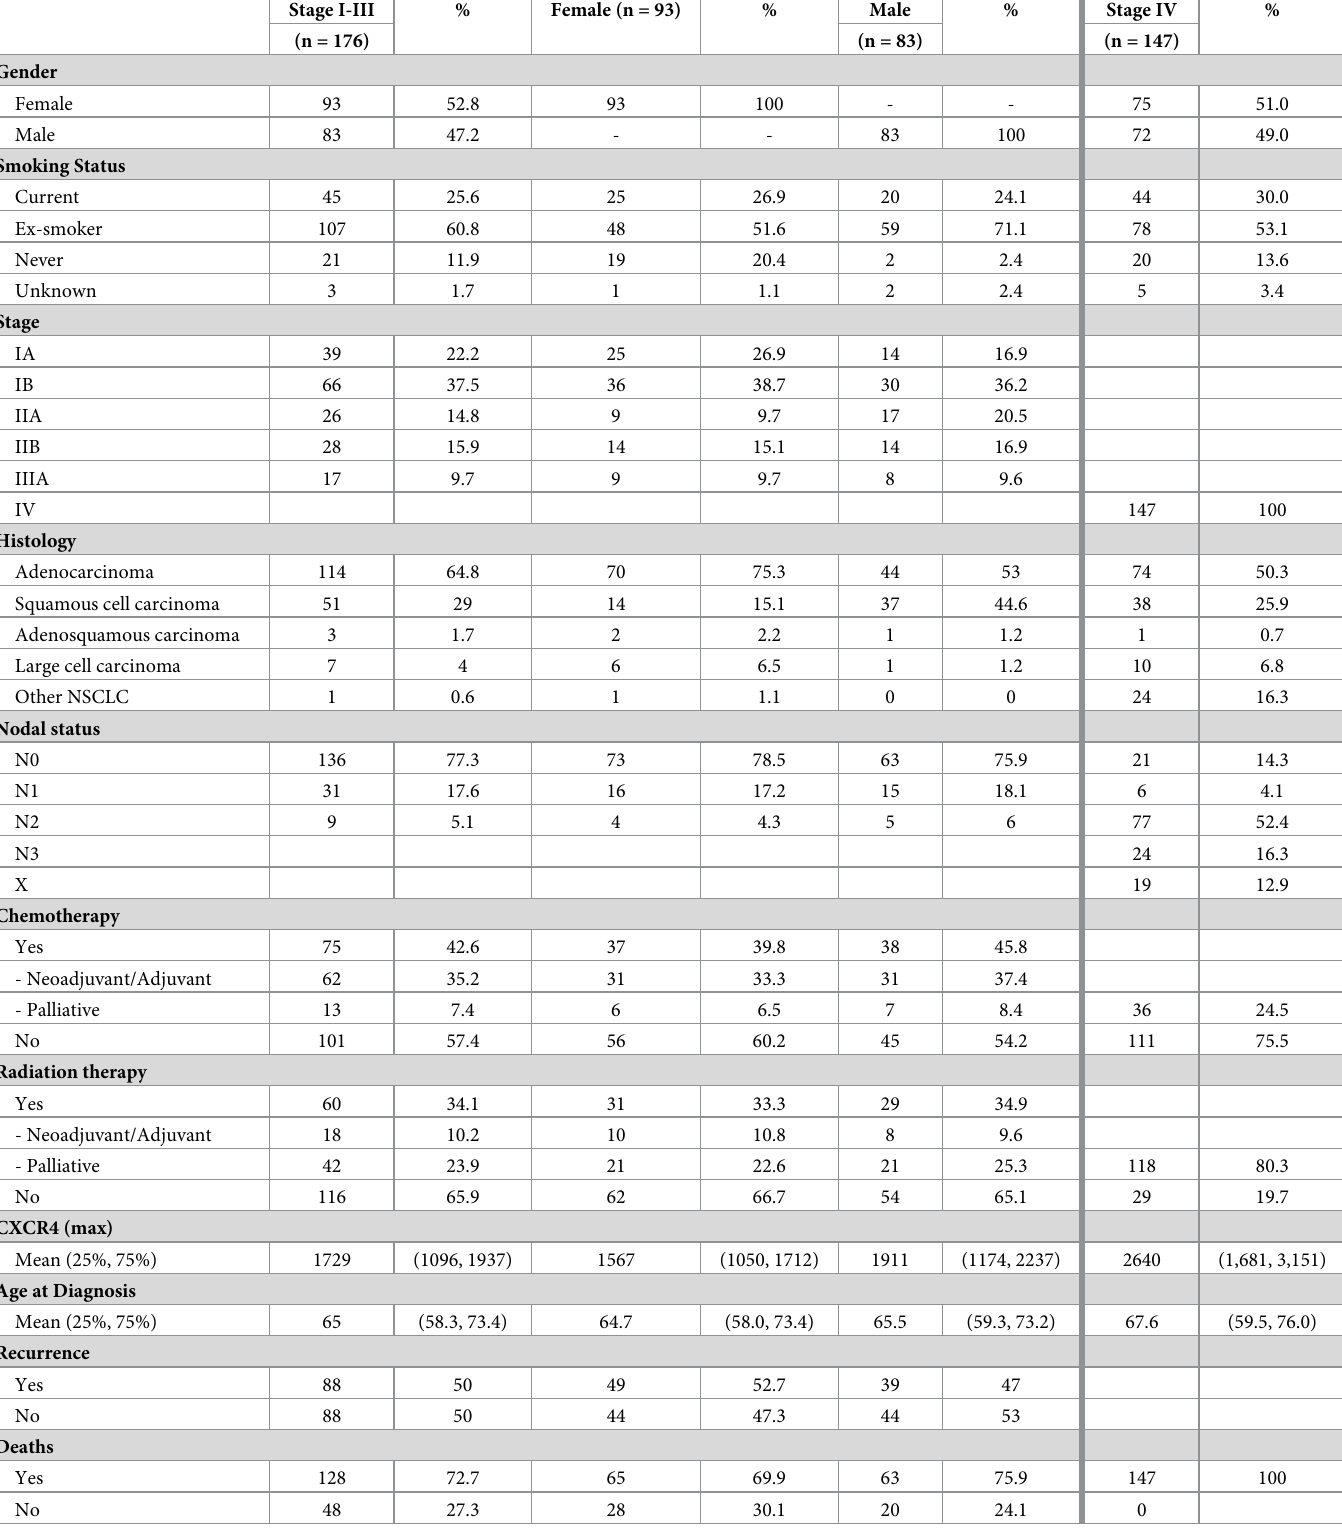
Table 1. Frequency and percent of patient and tumor characteristics at diagnosis for all patients and by